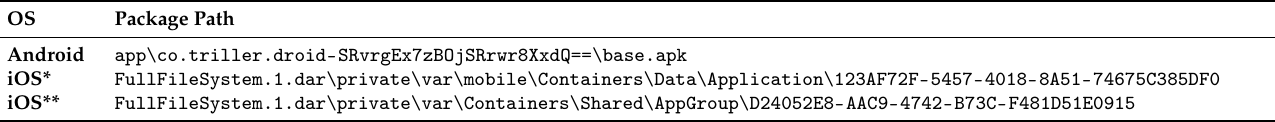
Table 7. Triller app package paths.